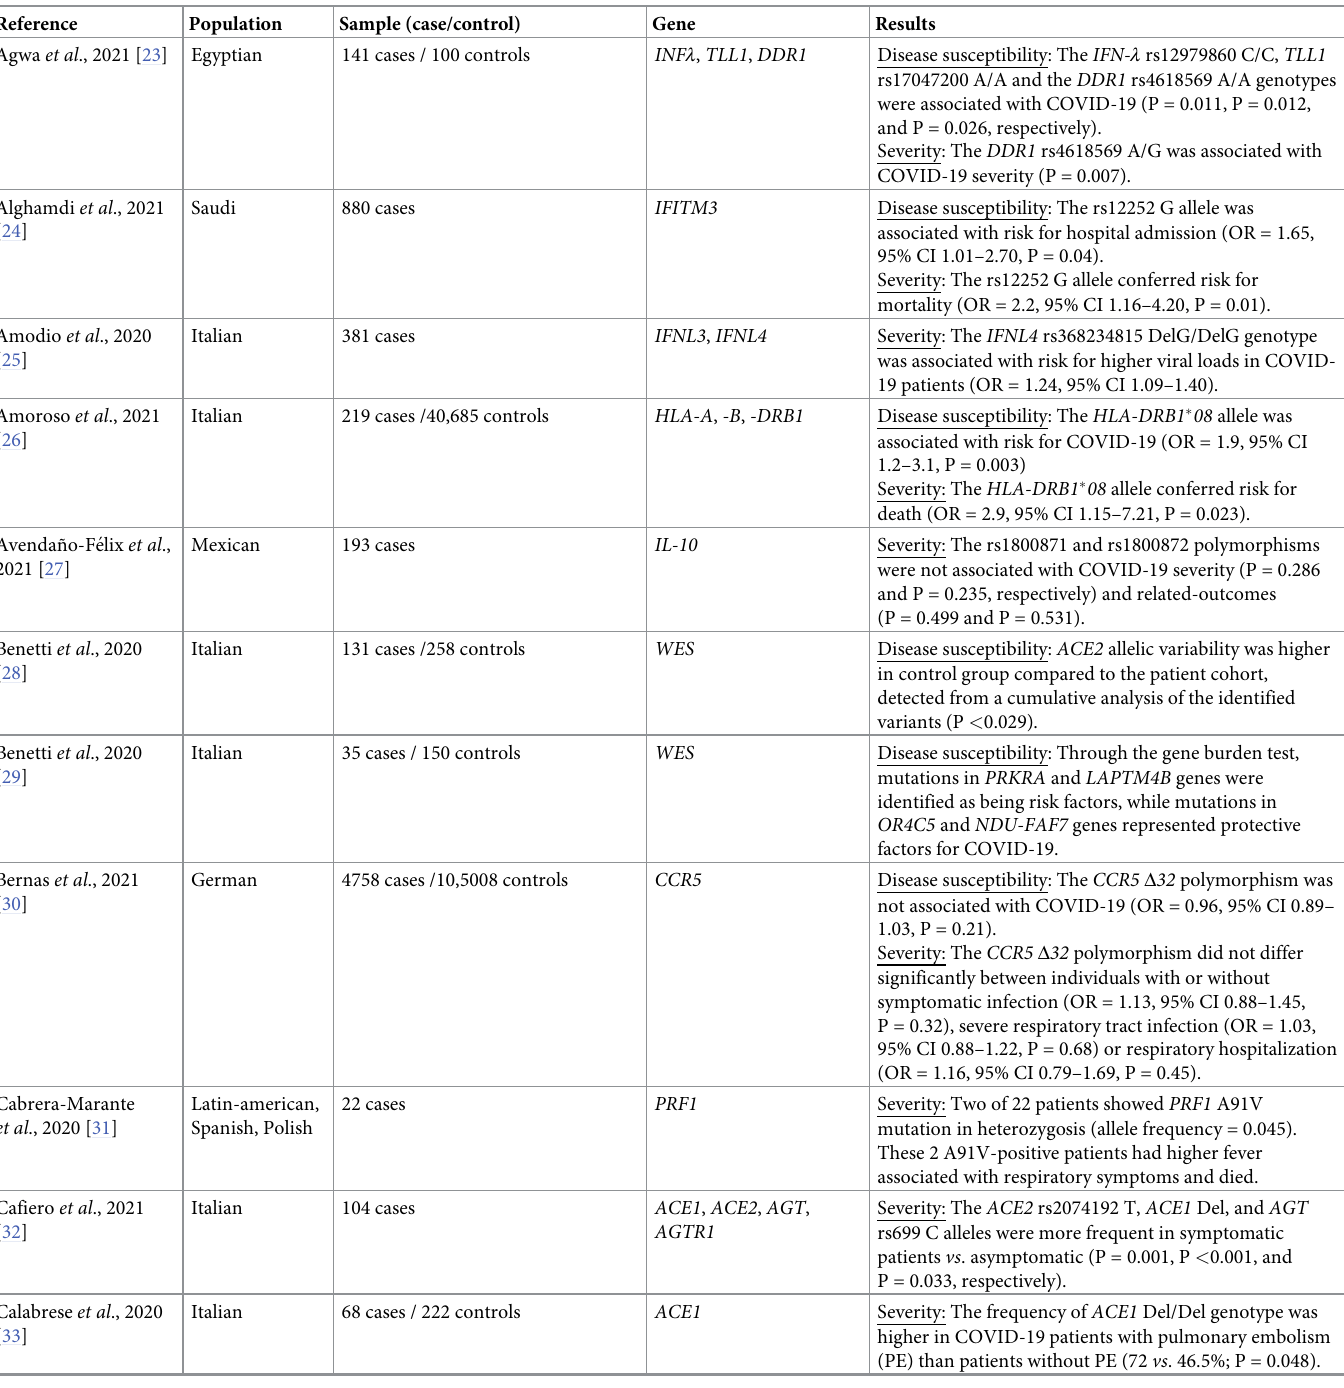
Table 1. Characteristics of studies included in the systematic review.